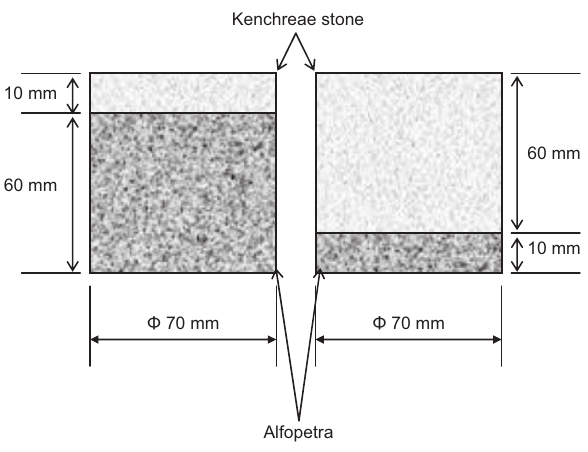
Figure 9 The confi guration of the specimens with modifi ed contact bases using patches of different